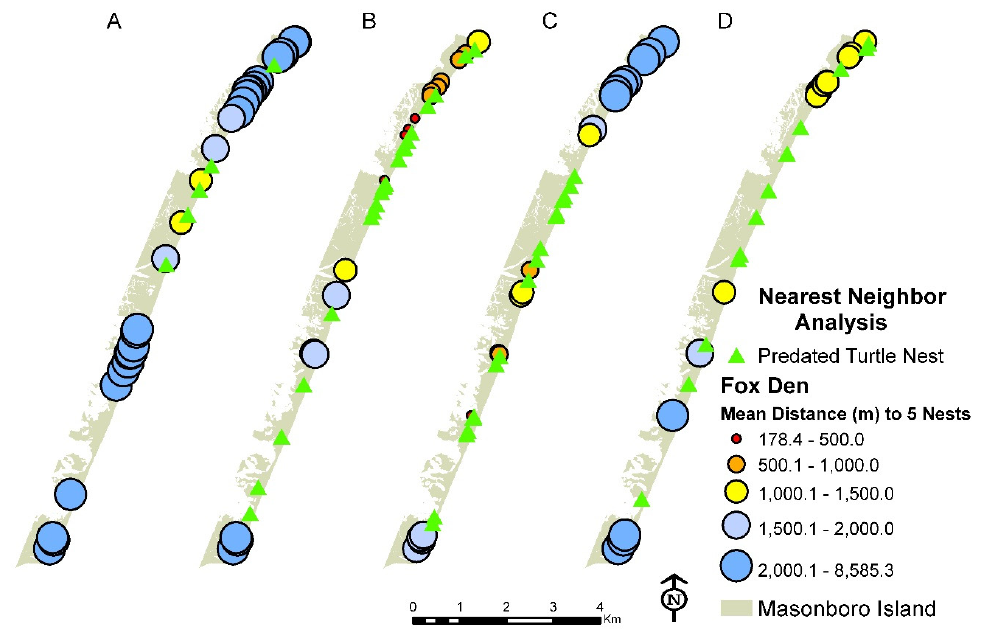
Figure 4. Mean distance to the nearest five predated sea turtle nests: ( A ) 2009 had random spatial autocorrelation, ( B ) 2010 had clustered spatial autocorrelation, ( C ) 2011 had clustered spatial autocorrelation, and ( D ) 2012 had clustered spatial autocorrelation.